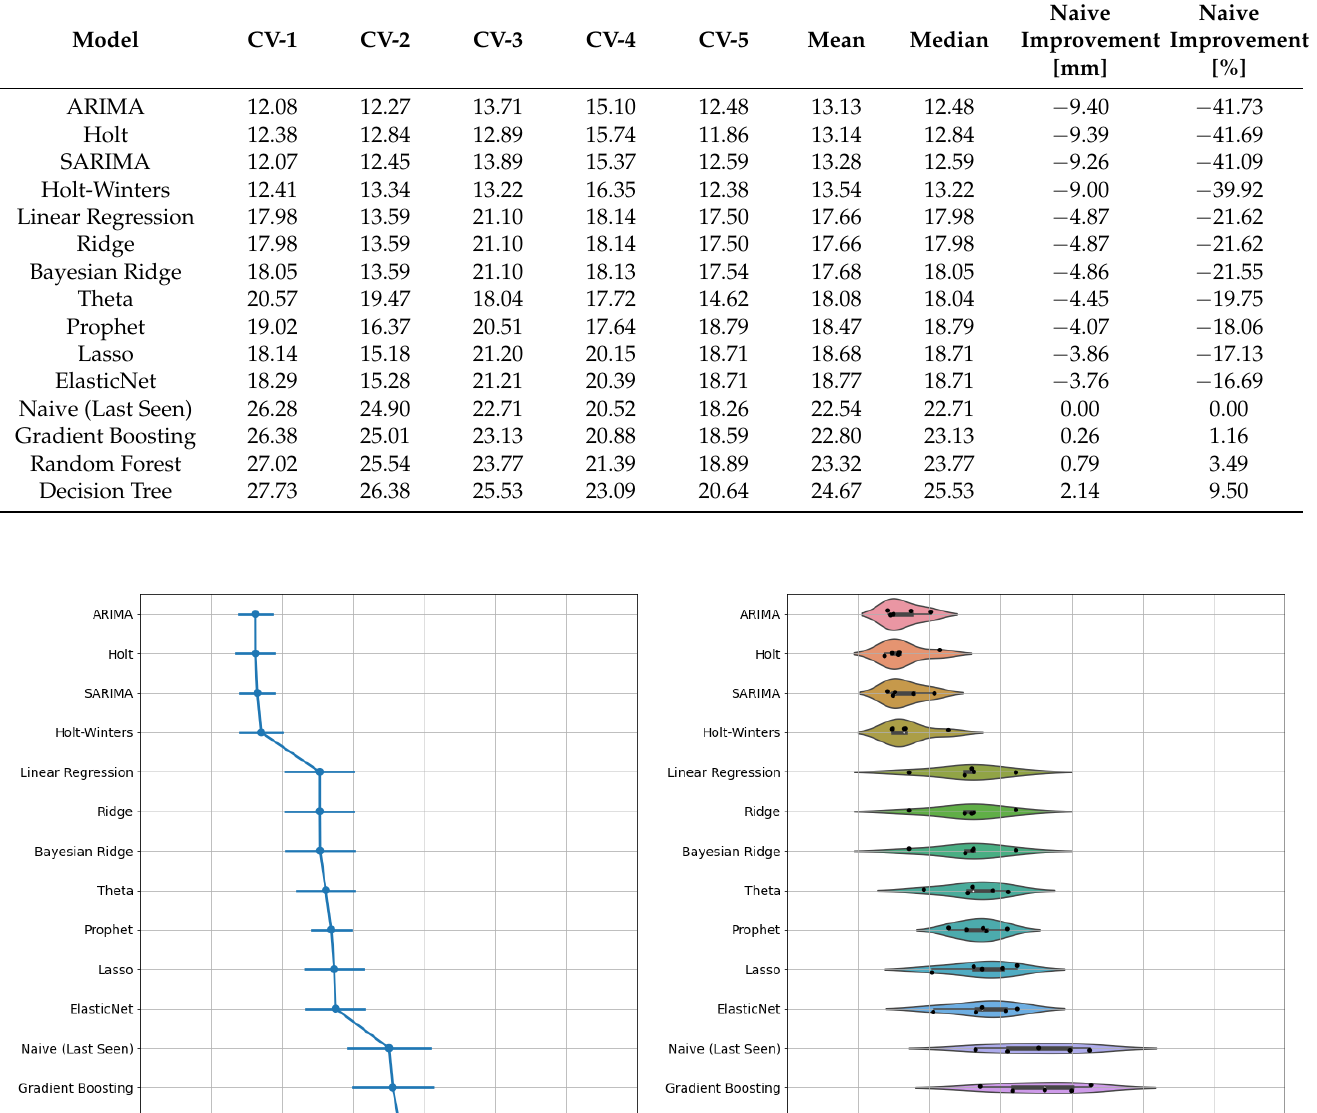
Table 4. Comparison of the calculated errors for all analyzed models.